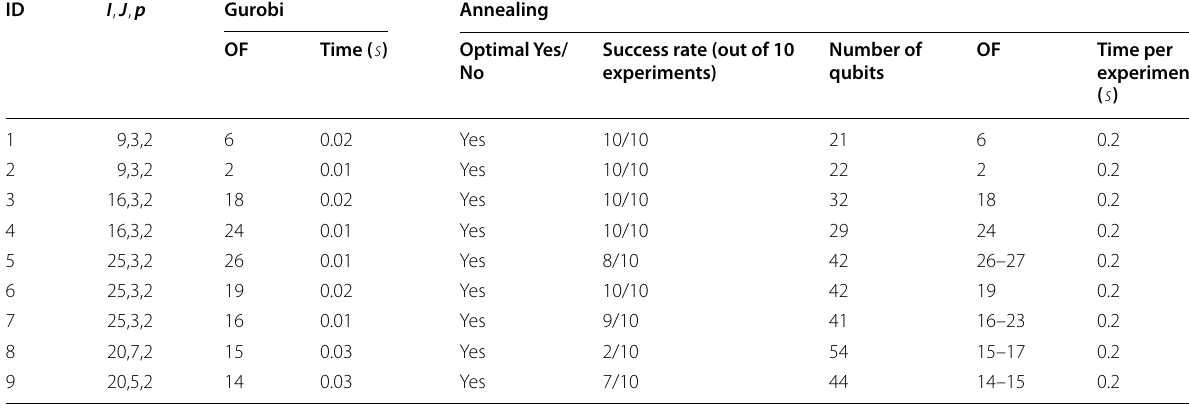
Table 5 Summary of annealing